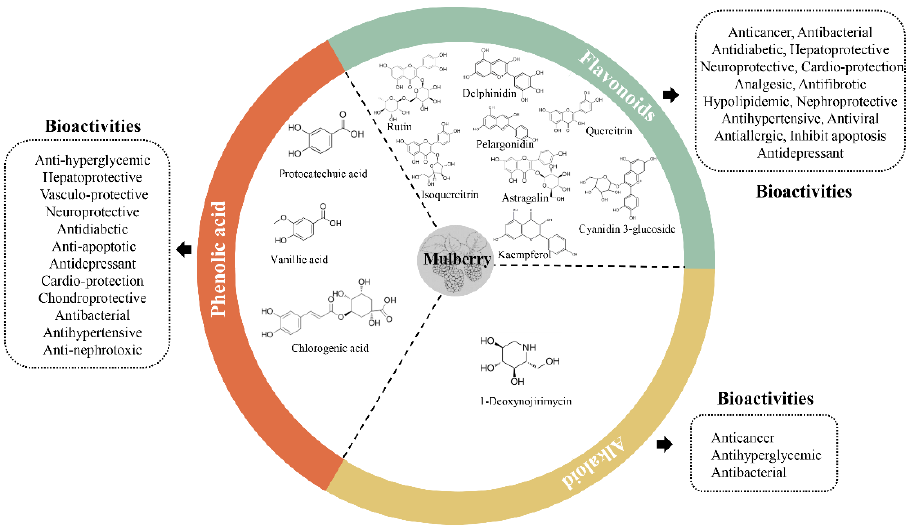
Figure 1. Main mulberry components and their bioactivities.